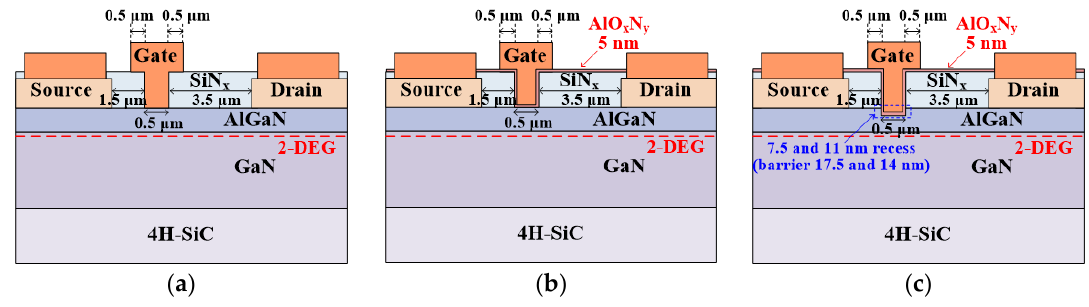
Figure 1. Cross-sectional schematics of the AlGaN/GaN high-electron-mobility transistors (HEMTs): ( a ) Schottky-gate, ( b ) non-recess metal-insulator-semiconductor (MIS), and ( c ) recess MIS structures.